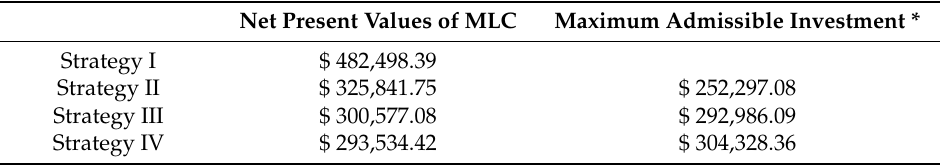
Table 15. Present values of maintenance labor costs considering the three maintenance